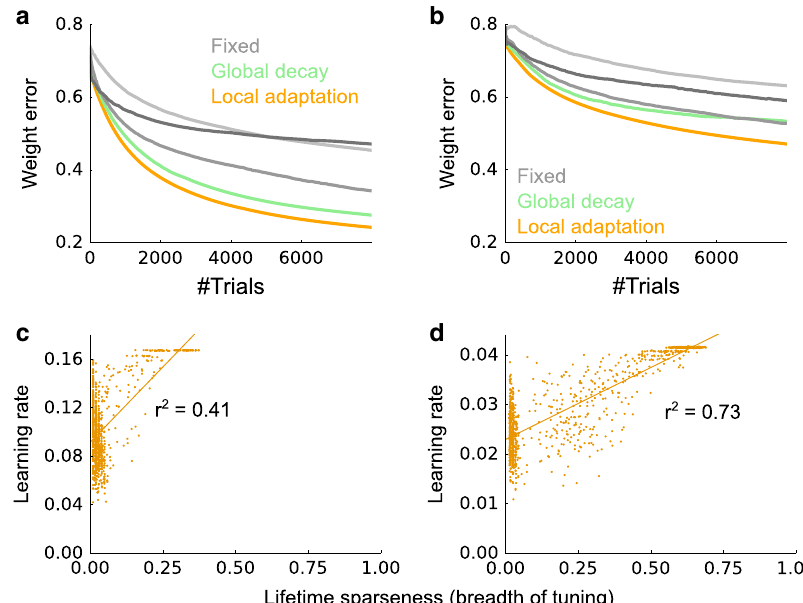
Fig. 6 Adaptive synaptic plasticity. a Weight error when 1 = t ρ t j is fi xed (gray lines), ρ t j is fi xed (light green), and fully adaptive (orange). For the gray lines we used learning rates of 0.01, 0.1, 1.0, correspond to light gray to dark gray. The sparsity, c o , was 0.03. b Same as panel a , but with a lower sparsity, c o = 0.07. c , d Correlations between the lifetime sparseness and the learning rate, after 300 stimuli were presented to the network, under more sparse ( c : c o = 0.03) and less sparse ( d : c o = 0.07) conditions. Lines are linear regressions, and each dot represents one granule cell. Correlation were signi fi cant for both c and d ( p ≪ 10 − 6 ). Vertical clusters appearing on the left edges of the panels correspond to neurons with very small lifetime sparseness. In all panels, M = 100 odors, N = 400 glomeruli, and 3 ( a , c ) or 7 ( b , d ) odors were presented on average. Light-green and orange lines in a and b are mean over 50 simulations, while the rest were calculated from 10